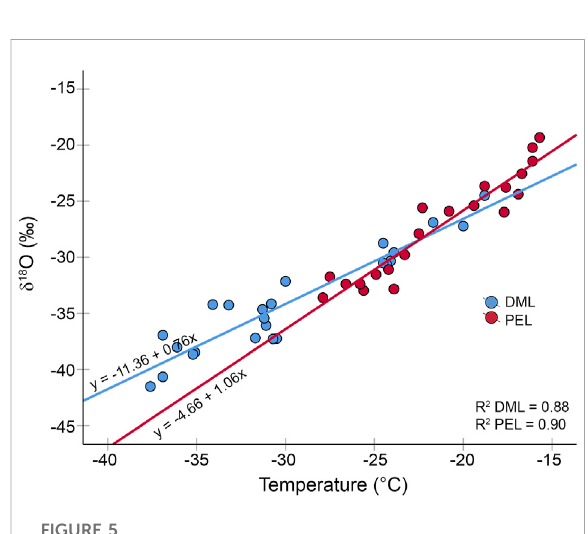
FIGURE 5 Relationship between δ 18 O and annual mean temperature (ERA-5) in DML and PEL